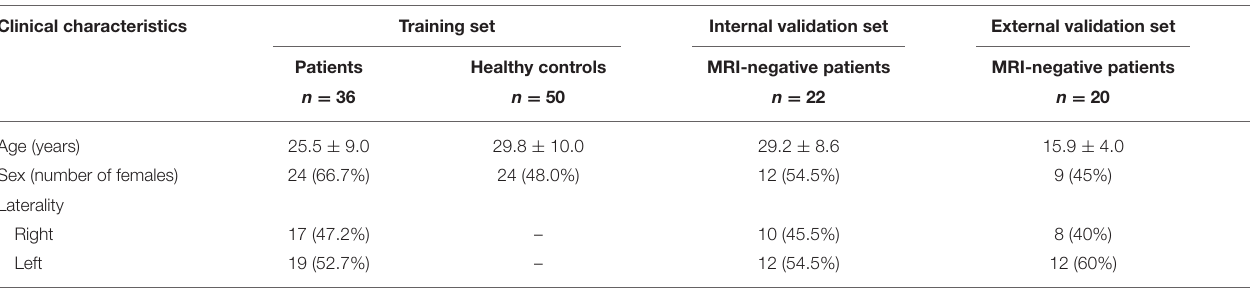
TABLE 1 | Patient characteristics in the training and validation